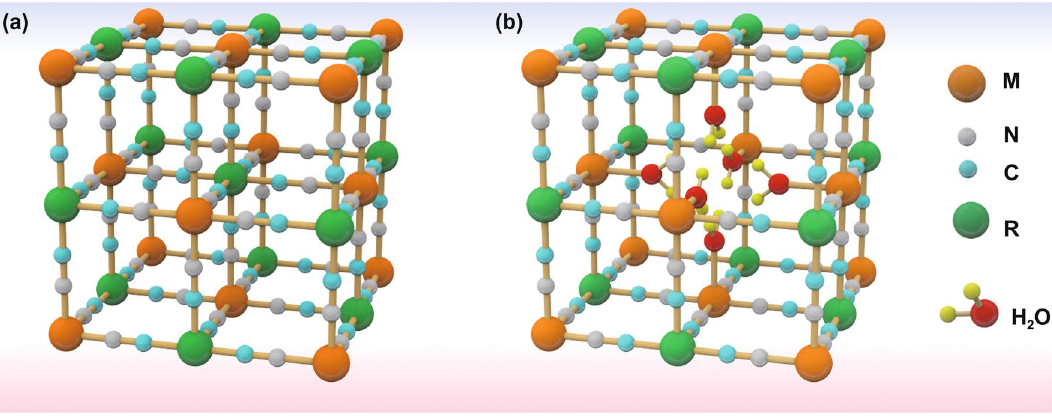
Fig. 2 a Schematic crystal structure of PBAs frameworks: An intact A x M[R(CN) 6 ] framework without structural defects. b A defective A x M[R(CN) 6 ] framework with vacancies and interstitial water existing in each unit